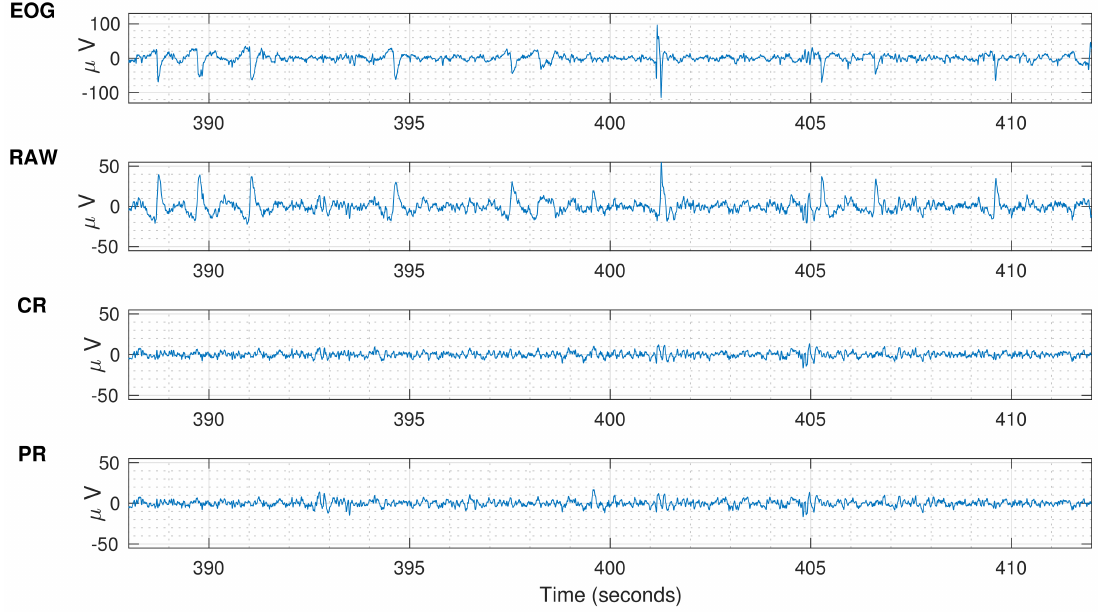
Figure 10. Example of signal of channel Fz before and after applying the considered schemes to diminish the influence of artifacts based on ICA analysis and complete IC removal (CR) and partial IC removal (PR) helped by manual artifact